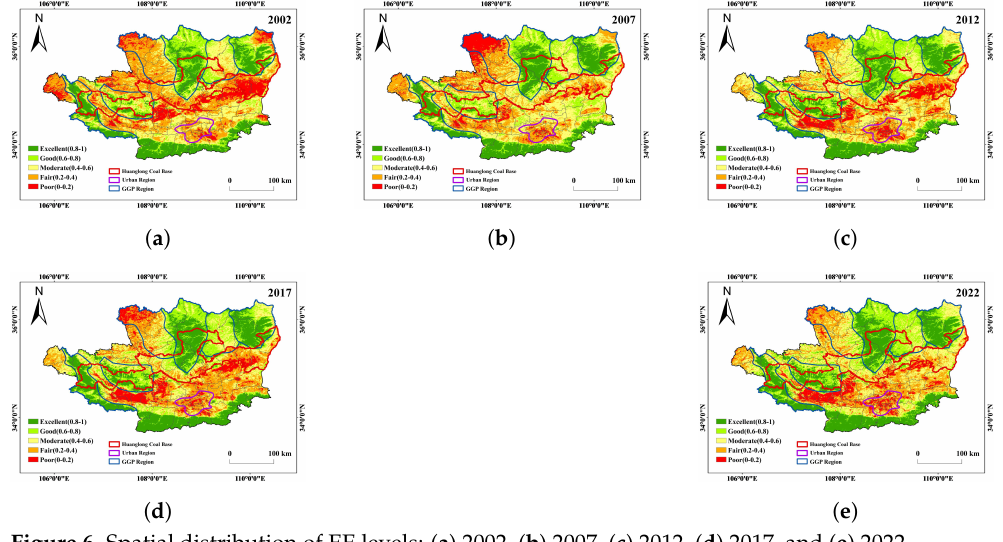
Figure 6. Spatial distribution of EE levels: ( a ) 2002, ( b ) 2007, ( c ) 2012, ( d ) 2017, and ( e ) 2022.